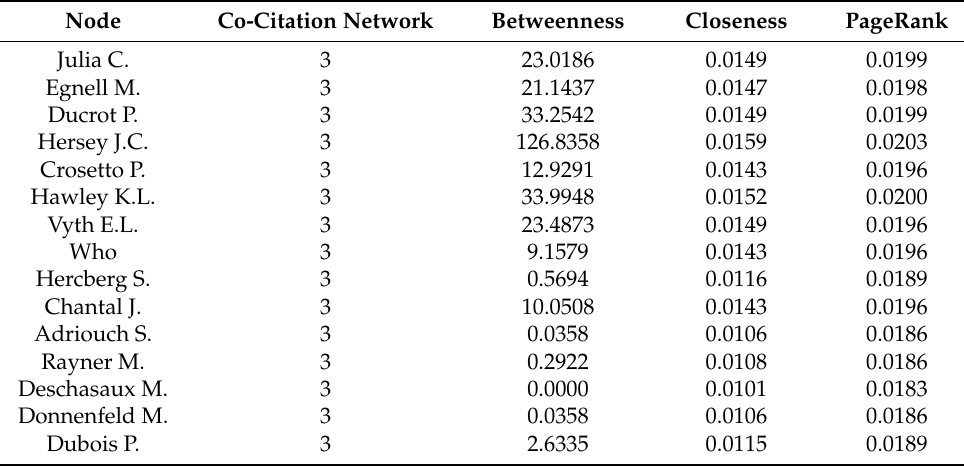
Table 19. Evolution of the relative strength of the nodes within the co-citation network 3. Node Co-Citation Network Betweenness Closeness PageRank Julia